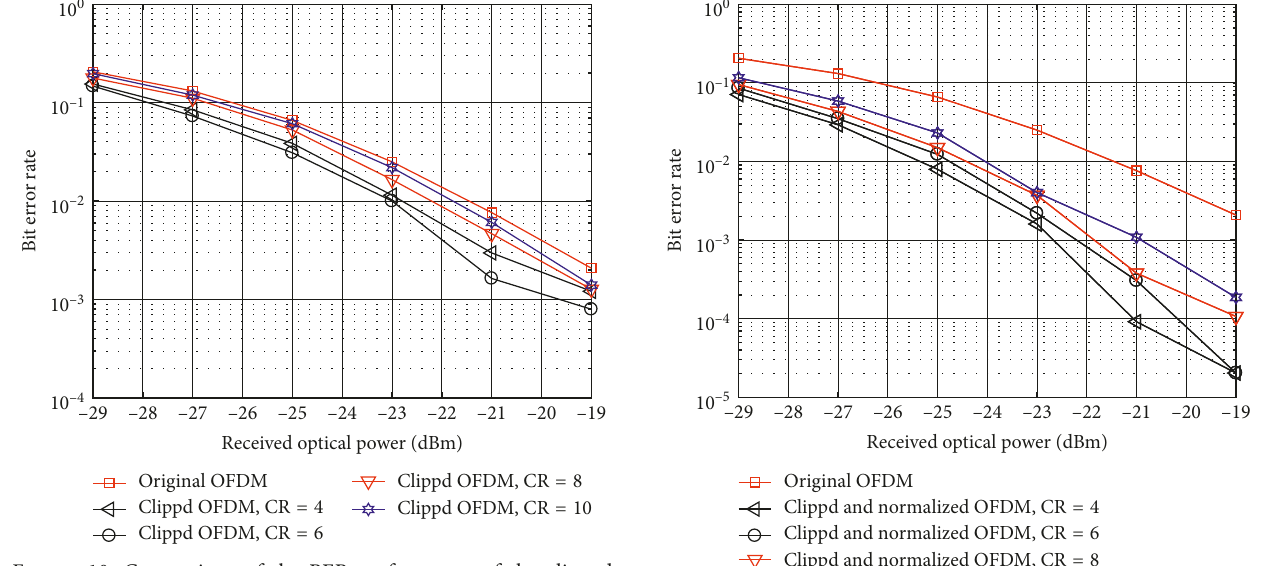
Figure 10: Comparison of the BER performance of the clipped QPSK OFDM signals with the launch power of